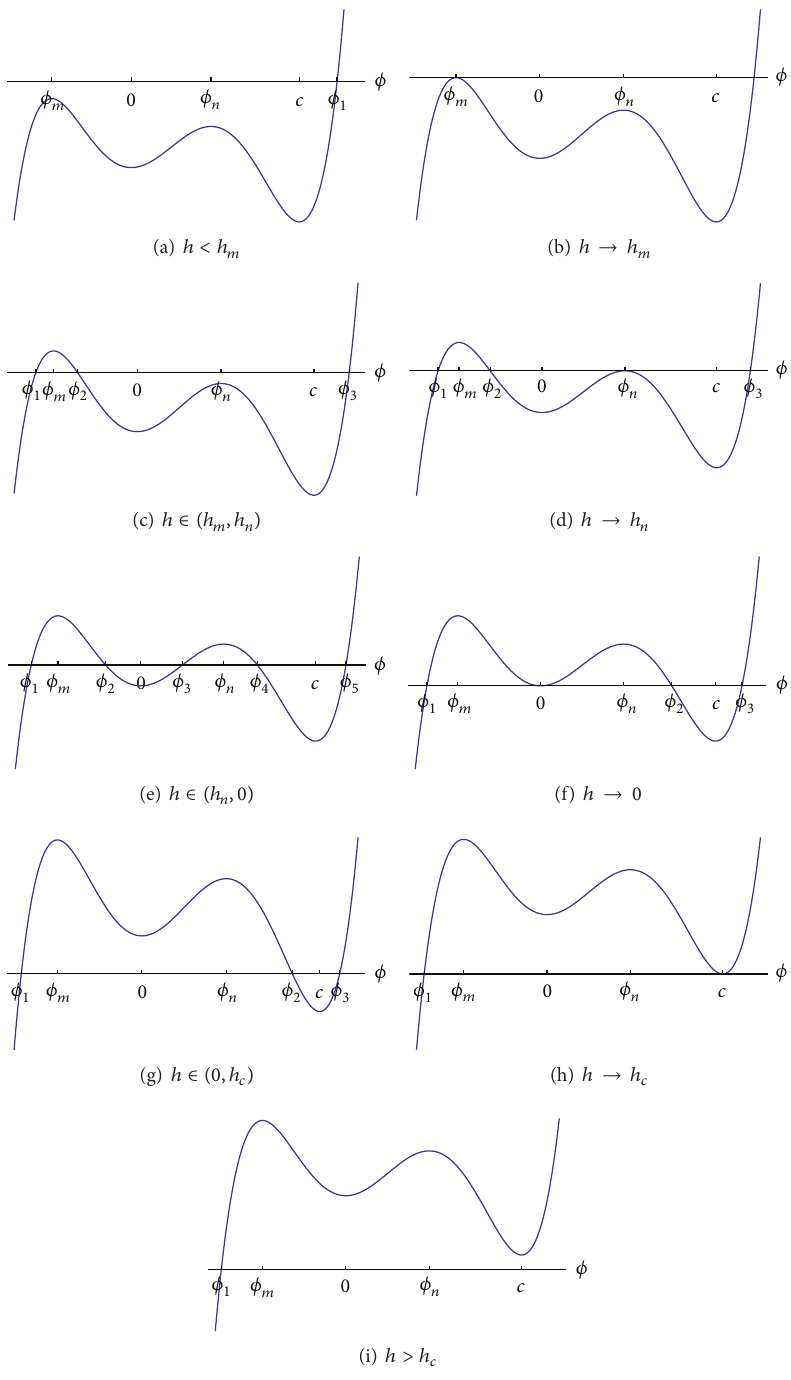
Figure 8: The graph of 𝐹(𝜙) as (1/5)(5𝑐 − 2𝑐 2 ) < 𝑐 0 < 𝑐